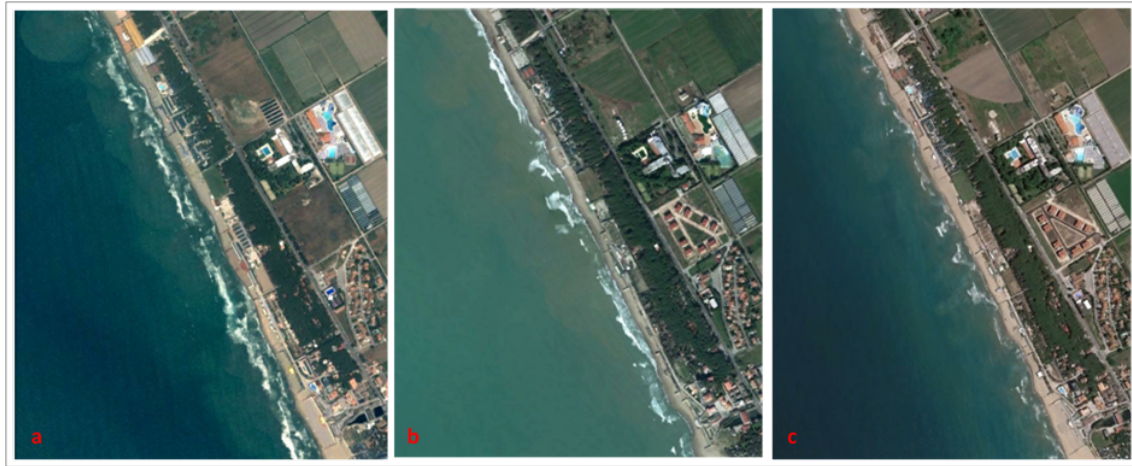
Figure 6. Evidence of rip currents in Google Earth ™ images on (a) 28 June 2007 (image © 2016 European Space Imaging), (b) 2 May 2013 (image © 2016 Digital Globe) and (c) 29 May 2015 (image © Landsat/Copernicus).